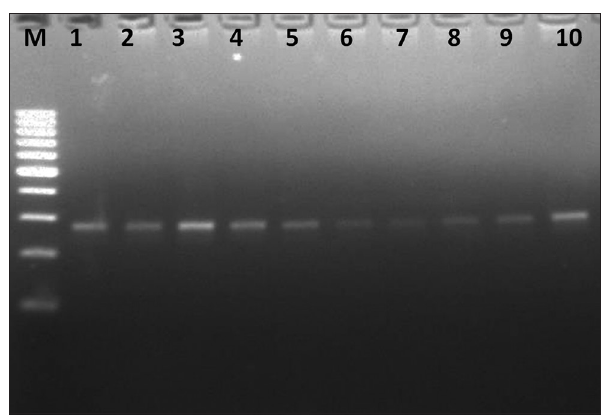
Figure-2: Agarose electrophoresis for amplified products. Lane M: 100 bp marker, lanes 1-10: Positive samples (275 bp).